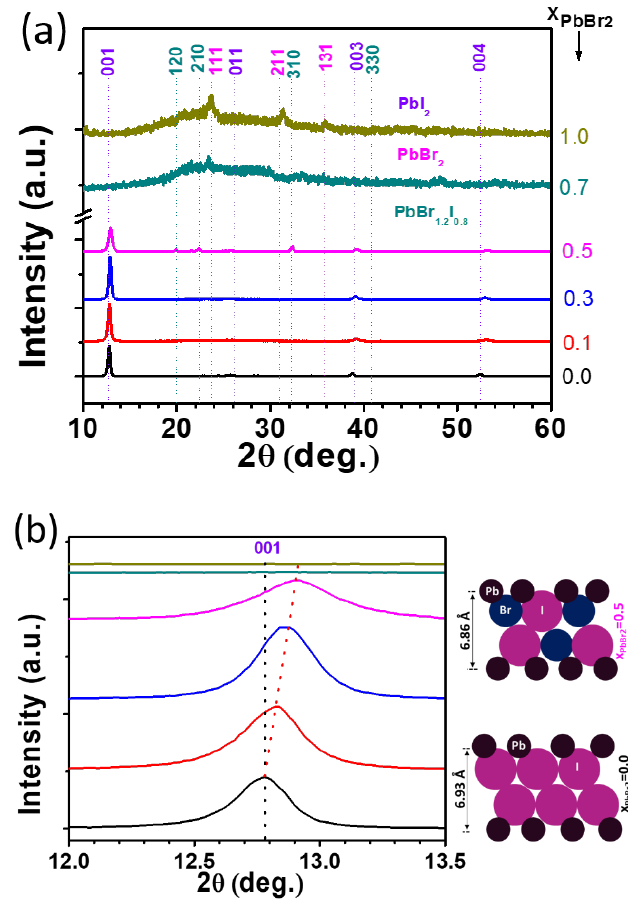
Figure 1. XRD patterns of ( a ) lead halide films deposited on a mesoporous TiO 2 at various mole fractions of PbBr 2 to PbI 2 ; ( b ) the peak shift of the (001) plane of PbI 2 to a higher 2θ with the increase in the ratio x and the schematic indicating the decreased distance between PbI 2 layers due to the replacement of I ions by Br ions.